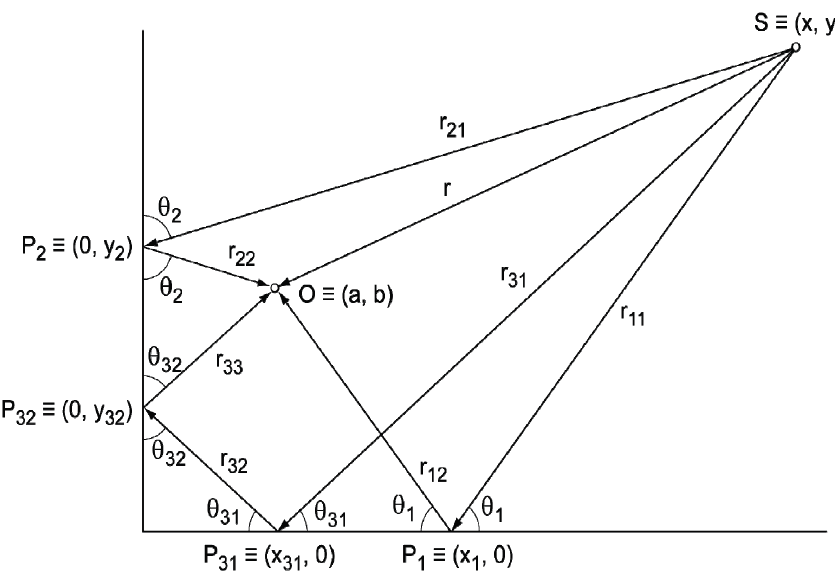
Figure 10. Multipath effects of sound reflections in a corner. The noise received by